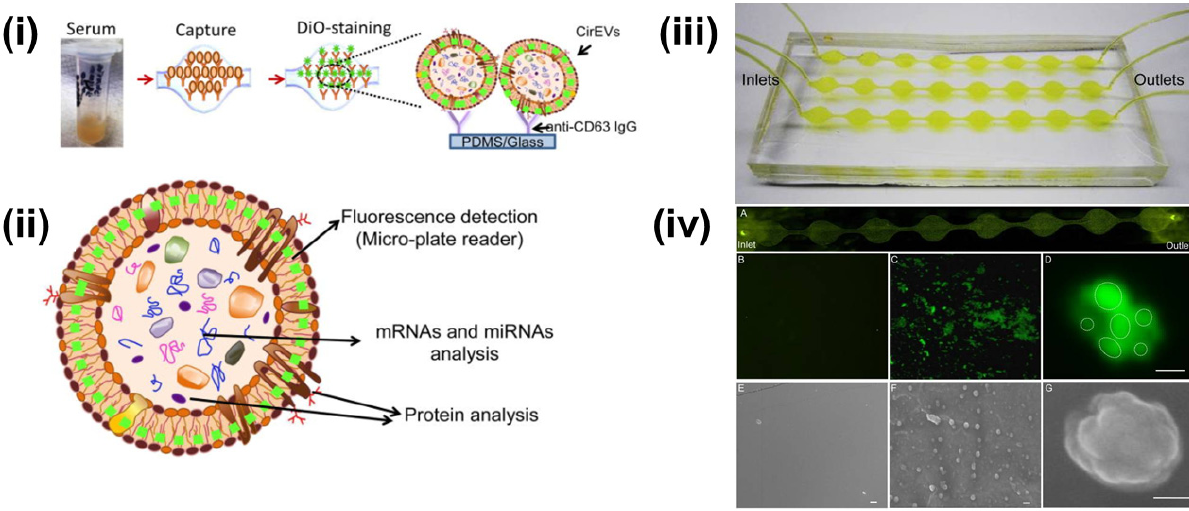
Figure 3. ( i ) Schematics of CD63 enrichment and membrane-specific DiO staining of exosomes using ExoChip platform. ( ii ) The fluorescent intensity of the DiO stained exosomes is measured using a fluorescent plate reader, while the genomic and the proteomic content can be characterized using Western blot or RT-qPCR analysis. ( iii ) Model of PDMS-based ExoChip. The device consists of multiple, connected circular chambers with a diameter of 5 mm and 100 µ m in height. ( iv ) Microscopy visualization of the exosomes and the ExoChip channel. ( A ) Fluorescence image of DiO stained exosomes immobilized to the lower surface of the device. Fluorescent image of the control chamber ( B ) and anti-CD63 coated chamber with captured exosomes ( C ), 400 × . ( D ) A confocal microscopic image of a cluster of exosomes (bar = 2 µ m). Electron micrograph (EM) images of control ExoChip ( E ) and anti-CD63 functionalized ExoChip ( F ) (bar = 500 nm). ( G ) EM image of a cluster of exosomes (bar = 100 nm). Reprinted (adapted) with permission from Kanwar et al., 2014. Copyright 2014, Royal Society of